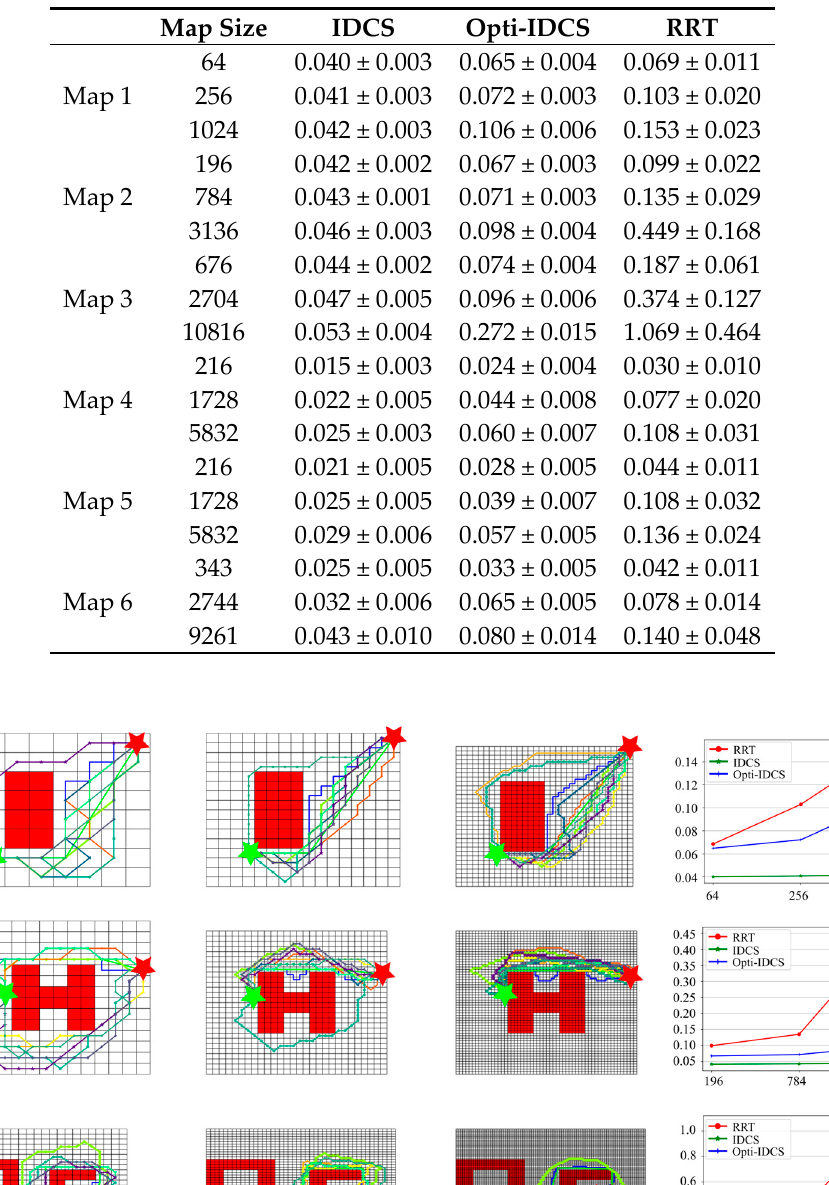
Table 5. Path generation time in maps of different